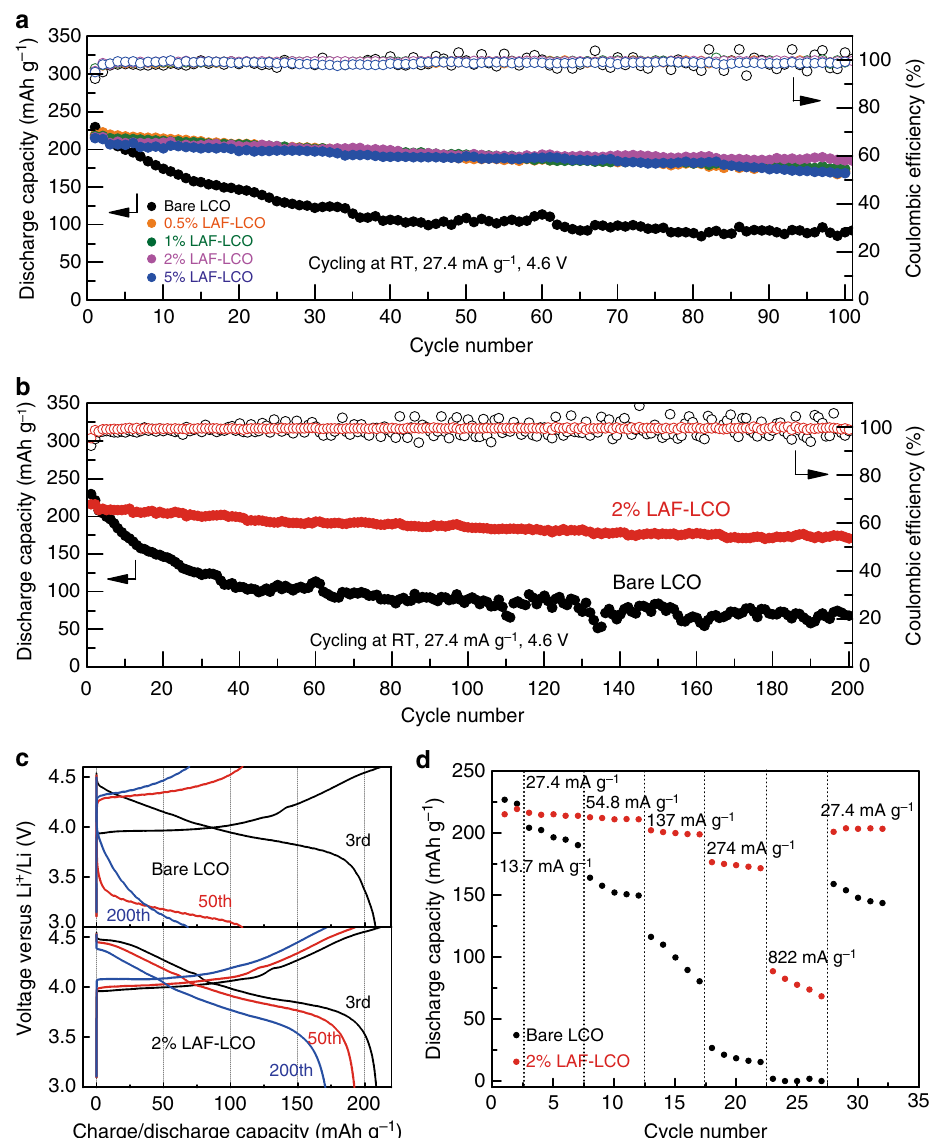
Fig. 4 Electrochemical performance of bare Li/LCO cells and Li/LAF-LCO cells. a Cycling performance of half-cells with bare LCO or LAF-LCO electrodes at room temperature in the voltage range of 3.0 – 4.6 V (vs. Li + /Li) at current density of 27.4 mA g − 1 . b Long-term cycling performance of half-cells with bare LCO or 2% LAF-LCO electrodes at room temperature in the voltage range of 3.0 – 4.6 V (vs. Li + /Li) at current density of 27.4 mA g − 1 . c Discharge-charge pro fi les of half-cells with bare LCO or 2% LAF-LCO electrodes at different cycles in the voltage range of 3.0 – 4.6 V (vs. Li + /Li) at current density of 27.4 mA g − 1 . d Rate performance of half-cells with bare LCO and 2% LAF-LCO electrodes at room temperature in the voltage range of 3.0 – 4.6 V (vs. Li + /Li). All cells were pre-cycled for two cycles at a low current density of 13.7 mA g − 1 . Source data are provided as a Source Data fi